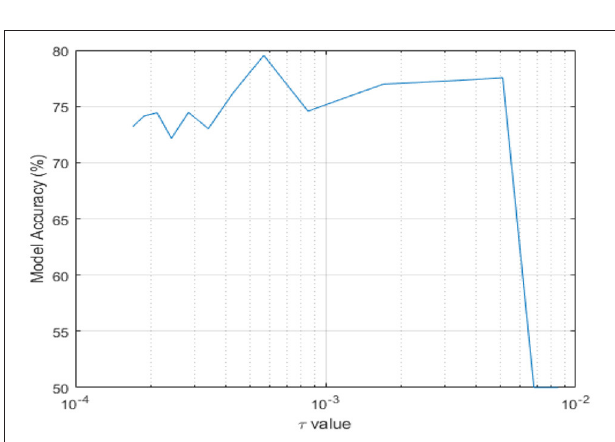
FIGURE 6 | Impact of the MEMS time constant on the classification accuracy in a